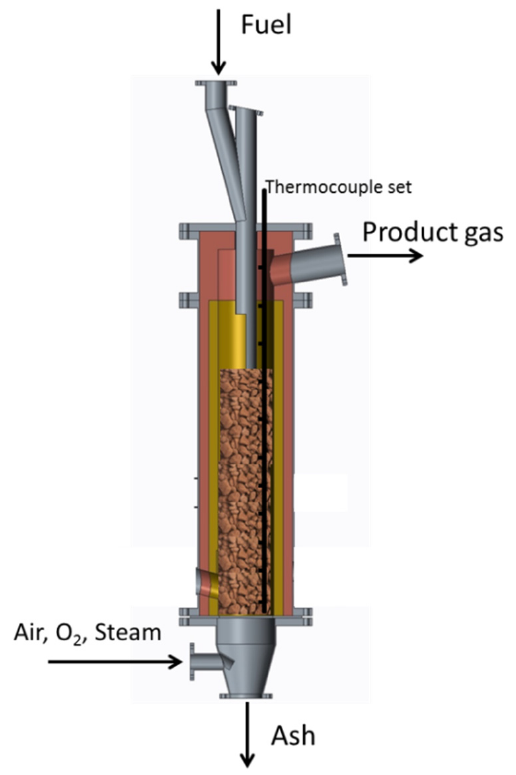
Figure 1. Scheme of the updraft gasifier.